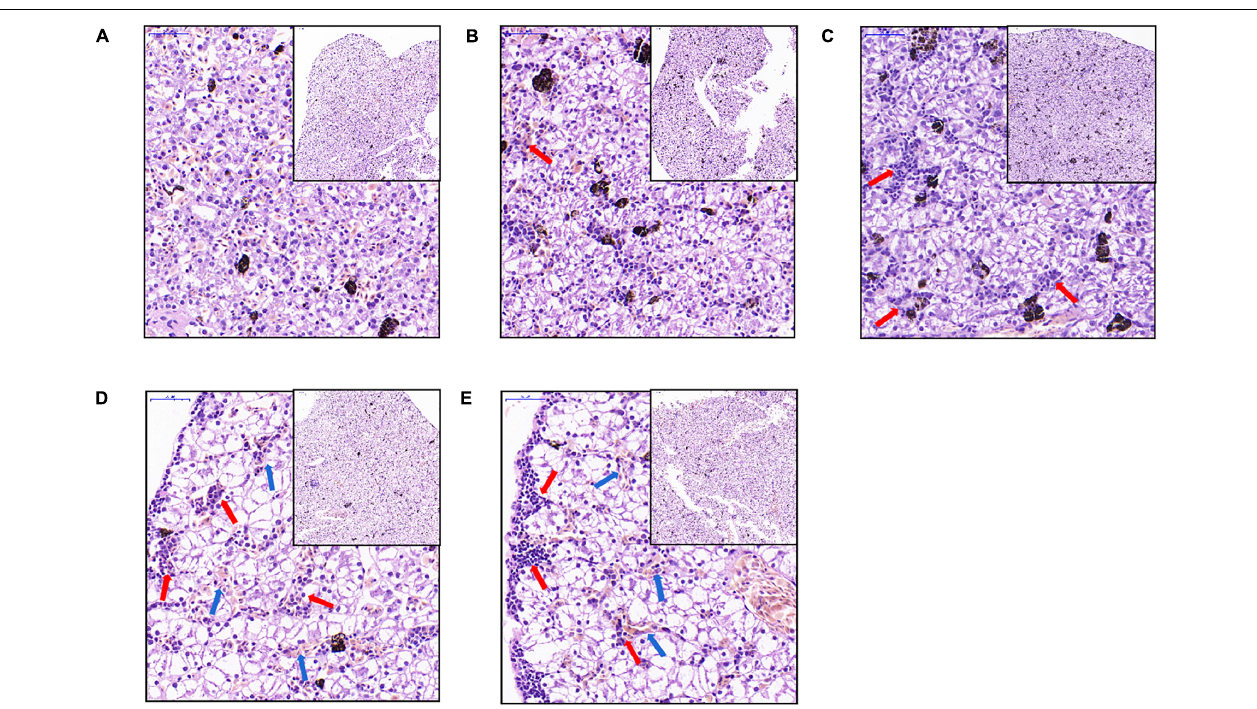
FIGURE 2 | Liver microstructural changes of Xenopus laevis exposed to different concentrations of MC-LR. (A–E) Indicate the liver micrographs of Xenopus laevis exposed to 0, 1, 5, 20, and 50 µ g/L MC-LR, respectively. Red and blue arrows indicate focal infiltration of inflammatory cells and congestion, respectively.